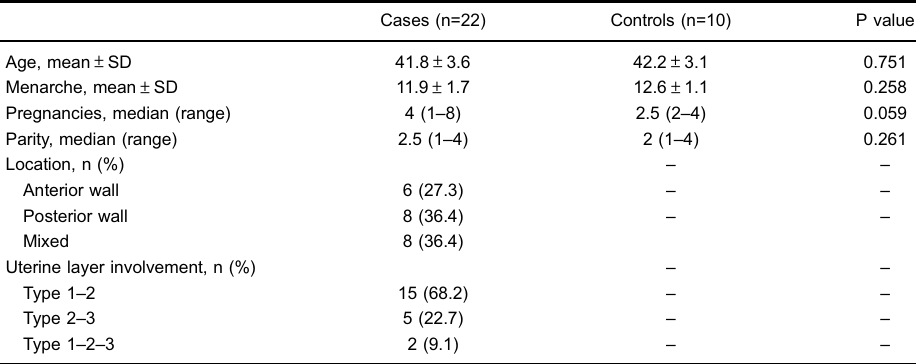
Table 2. Clinical characterization of patients included in the study.